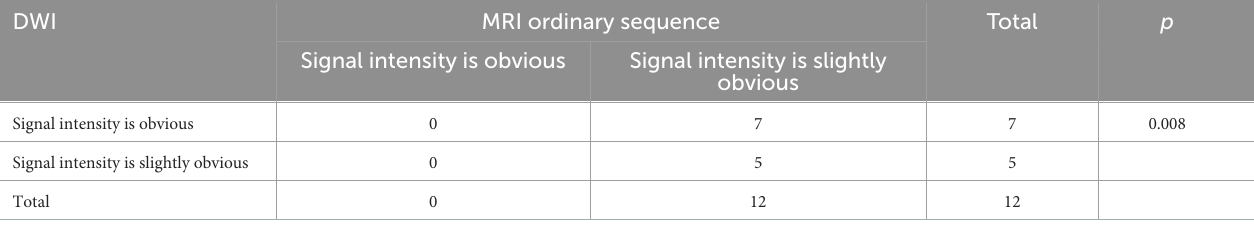
TABLE 6 Signal intensity distribution of severe HACE DWI sequence and MRI ordinary sequence in 18 cases. DWI